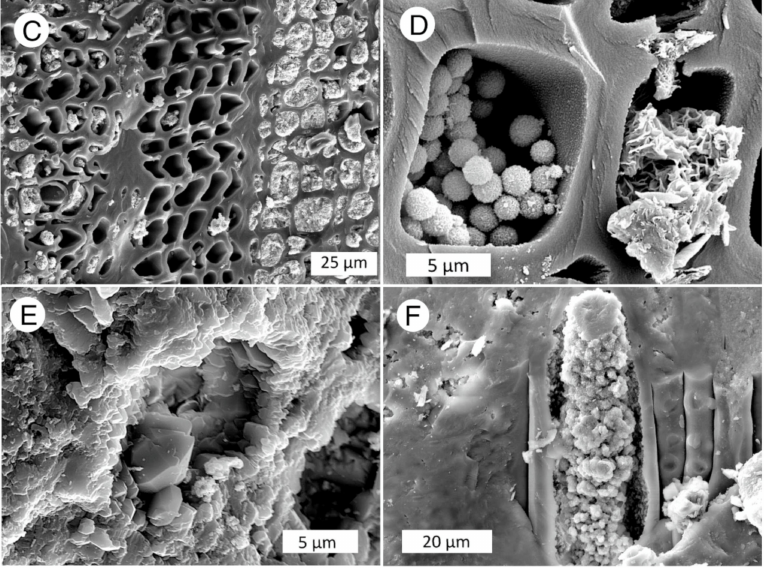
Figure 35. Fossil wood showing precipitation of silica in open spaces. ( A ) Eocene Sequioxylon wood showing wood fibers with thick cell walls, with lumen filled with fine-grained silica. Florissant Fossil Beds National Monument, Colorado, USA. Specimen provided by Herbert Meyer. ( B ) Miocene wood from Gabbs, Nevada, USA. Scattered euhedral quartz crystals have precipitated on a cell wall that was replaced by opal-A. ( C , D ) Fossil wood from Royal Peacock Mine, Virgin Valley, northern Nevada, USA. Specimens provided by John Church. ( C ) Transverse view shows three annual rings in carbonized wood. Cells in the central zone are mostly unmineralized. Some cells in the left layer contain clay minerals. Cells in the zone to the right are mostly filled with porous opal. ( D ) High magnification view of two cells, one containing opal-CT lepispheres, the other partially filled with a clay mineral. ( E ) Cell with fibrous chalcedony replacing cell walls, with euhedral quartz in lumen. From Miocene wood from Gardinier Phosphate Mine in Polk County, Florida, USA. Specimen provided by Harry Miller. ( F ) Crystalline quartz filling a cell lumina in opalized Miocene wood from Terrace Heights, near Yakima, Washington, USA. Specimen provided by T.A.